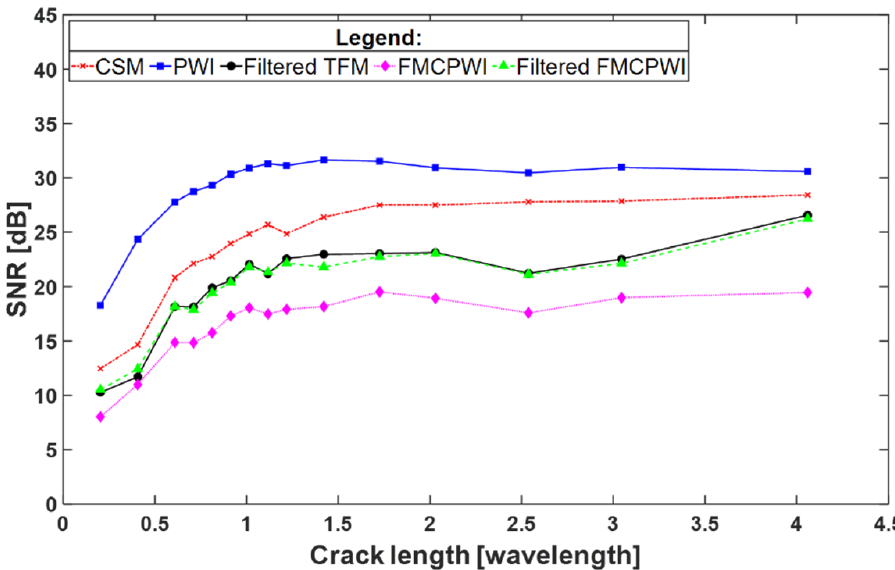
Figure 13. SNR vs. true crack length for 50% through wall thickness notch measured from CSM, PWI, filtered TFM, unfiltered FMCPWI and filtered FMCPWI reconstructions obtained from experimental data.